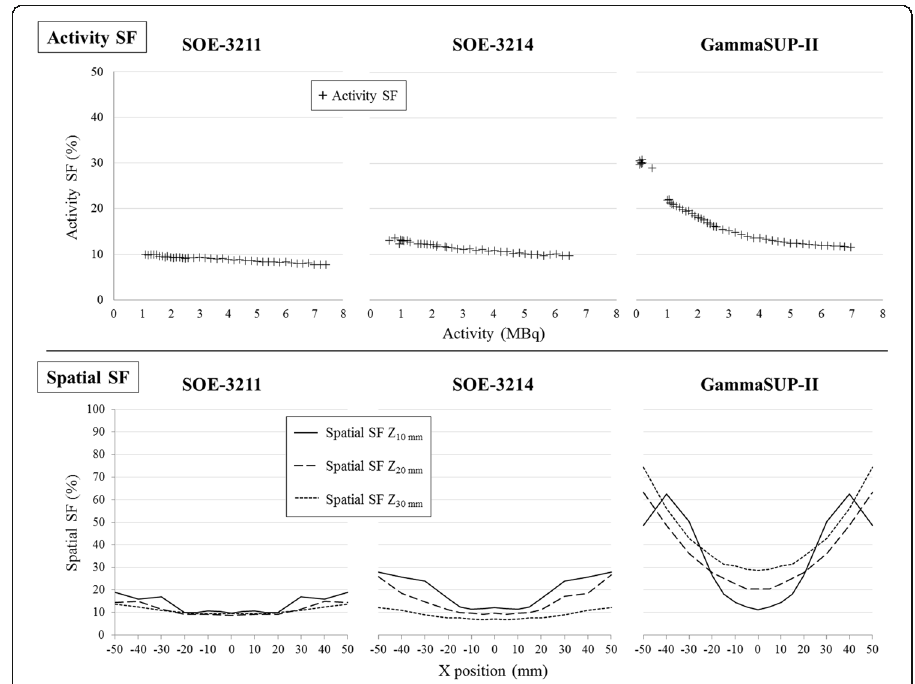
Fig. 8 99m Tc scatter fractions according to the source activity and the probe positioning for the three